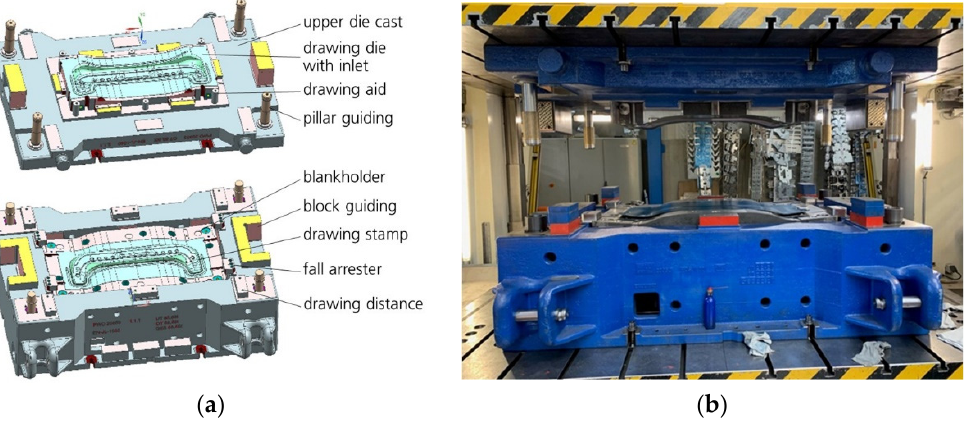
Figure 5. ( a ) Geometry of forming tool created for the experimental research by CAD with upper and lower tool part; ( b ) manufactured tool mounted in hydraulic press during experiments.